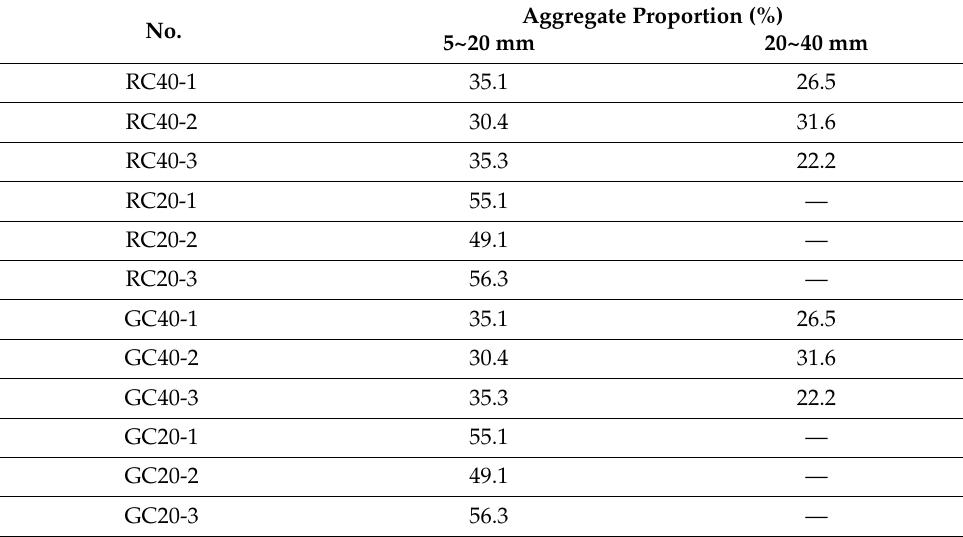
Figure 1. Concrete specimens with different gradations and different expansion modes. ( a , b ): Yellow—aggregates with MAS = 20 mm, orange—aggregate with MAS = 40 mm, light gray—mortar. ( c – h ): Cyan—aggregate with MAS = 20 mm, green—aggregate with MAS = 40 mm, gray—mortar, black—gel pocket. Table 1. Aggregate proportions of concrete specimens.